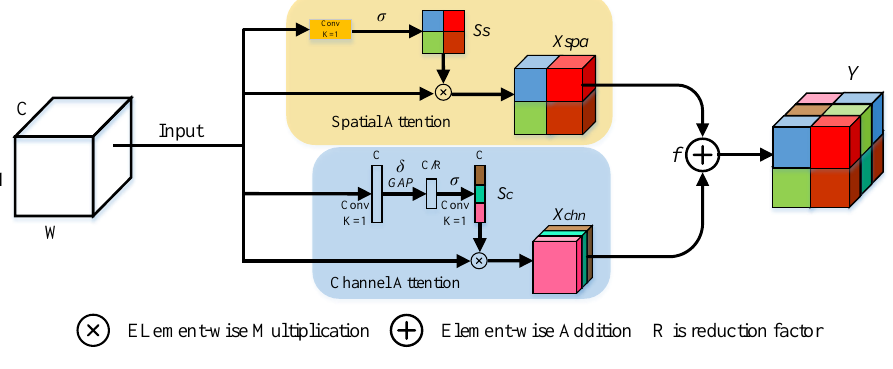
Figure 3. Structure of scSE.